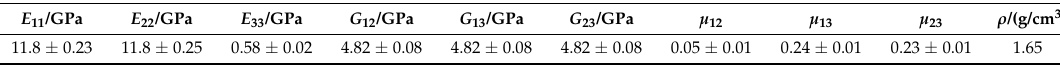
Table 3. Elastic parameters obtained in the mechanical test.